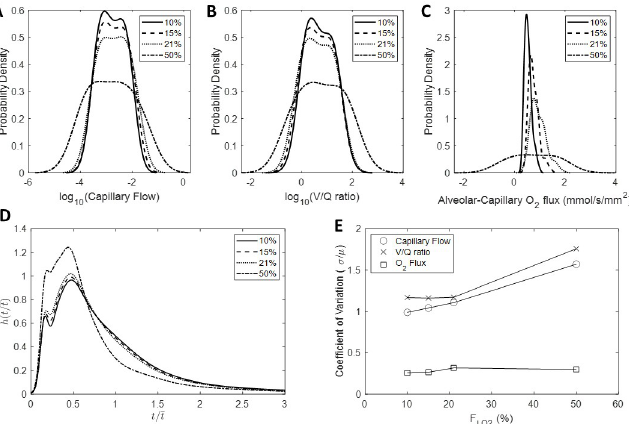
Fig 9. Effect of the fraction of inspired oxygen on HPV-mediated redistributions in hemodynamics, V/Q matching, and oxygen flux. (A) Distributions of capillary blood flow; (B) Distributions of V/Q ratios; (C) Distributions of oxygen flux; (D) RBC transit time distributions; (E) Coefficient of variation of blood flow, V/Q ratio, and oxygen flux plotted as a function F i,O2 .